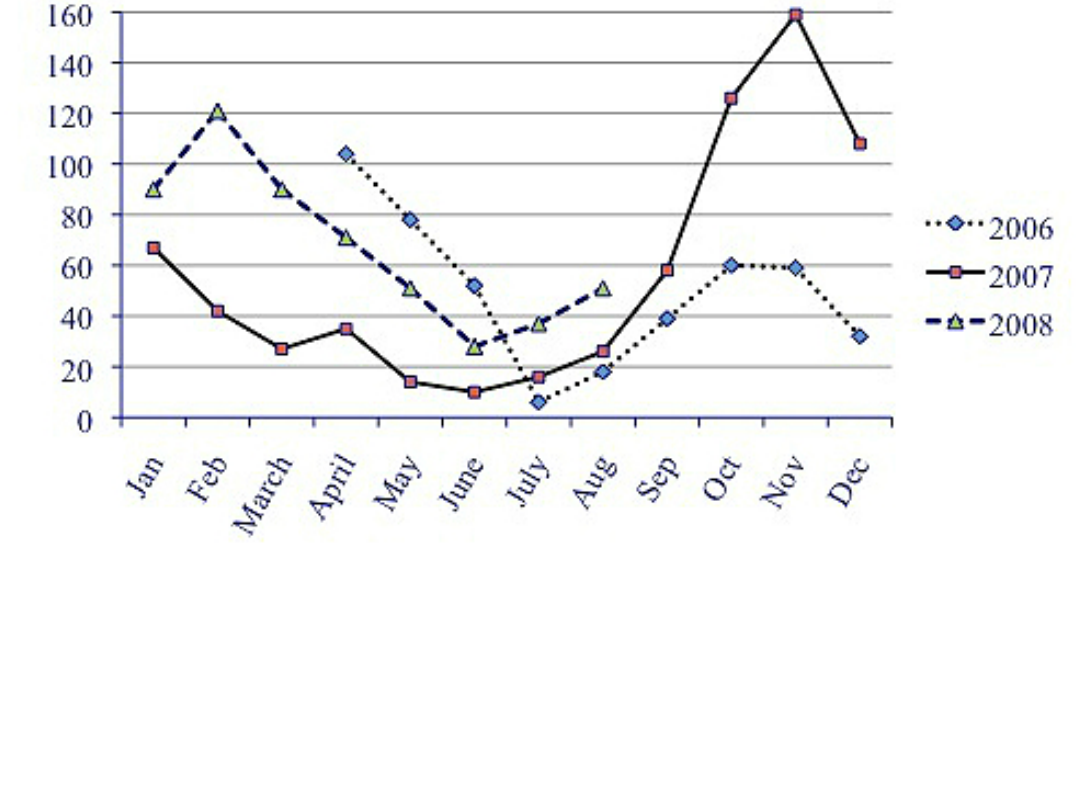
Figure 5. Site visits per month by patients and parents (study year 2 started